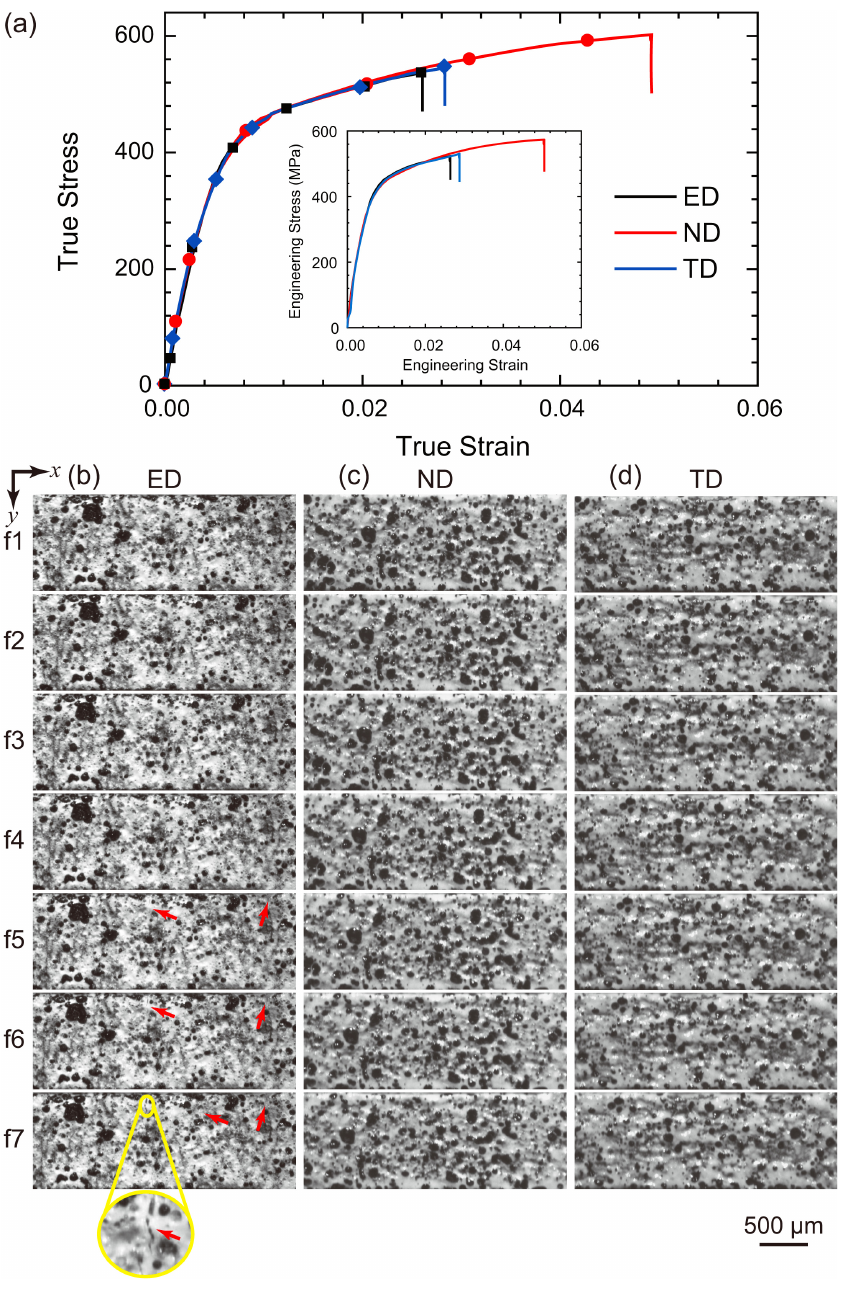
Figure 8. ( a ) True stress–strain curves and ( b – d ) snapshots of CNT/2024Al composite under quasi- static tensile loading at 10 − 3 s − 1 along the ( b ) ED, ( c ) ND and ( d ) TD. The inset in ( a ) is The corresponding engineering stress–strain curves. Frames f1–f7 are indicated with symbols in ( a ). The inset in ( b ) is an enlarged view of a crack. The cracks are pointed out by red arrows. As for the CNT/2024Al composite with lamellar microstructures, plastic deformation is prone to nucleate and grow at the lamellar interfaces [5]. Due to the hot